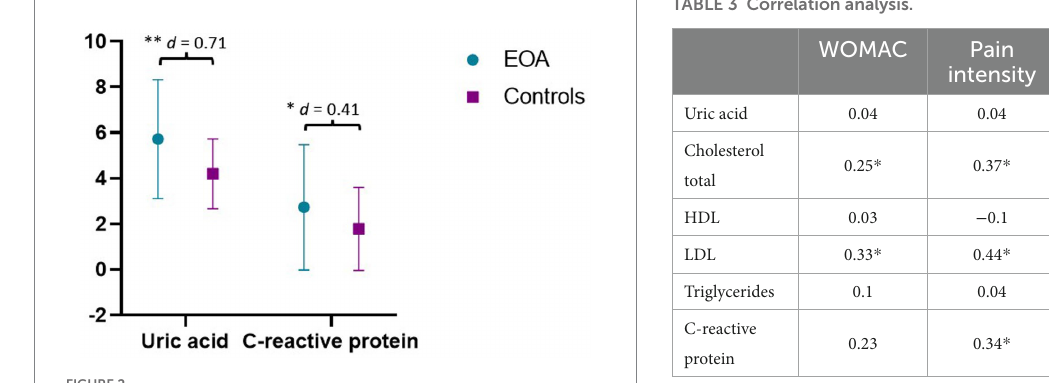
TABLE 3 Correlation